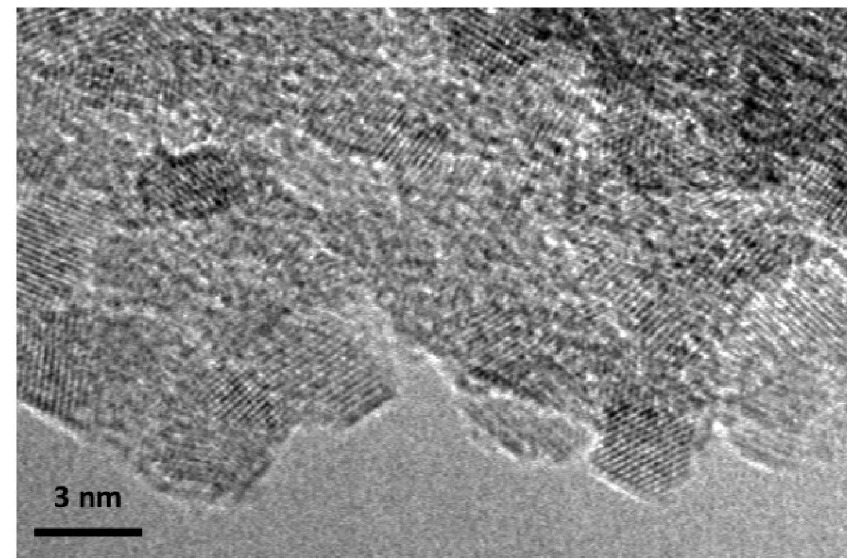
structure. The x N 3 4